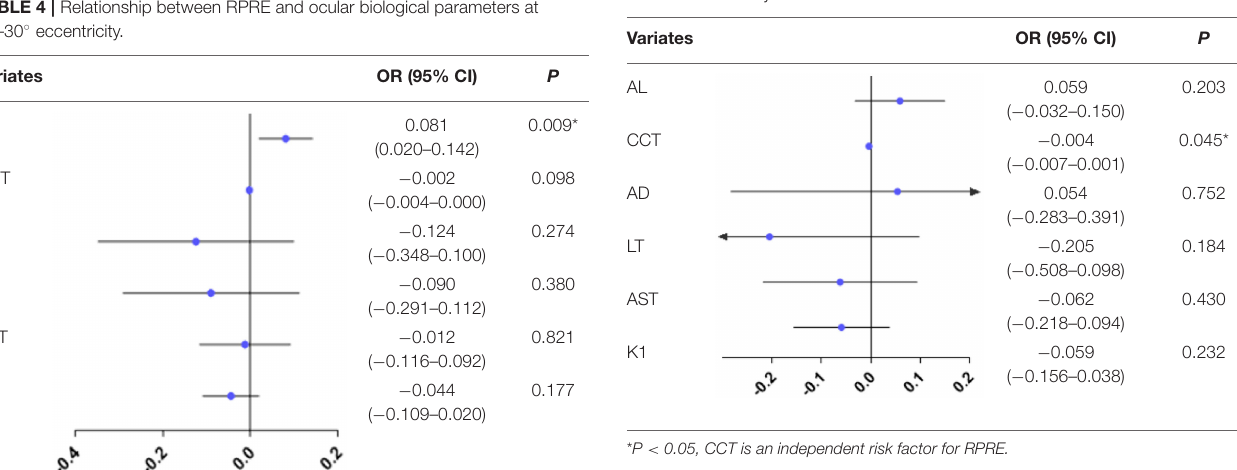
TABLE 6 | Relationship between RPRE and ocular biological parameters at 35–40 ◦